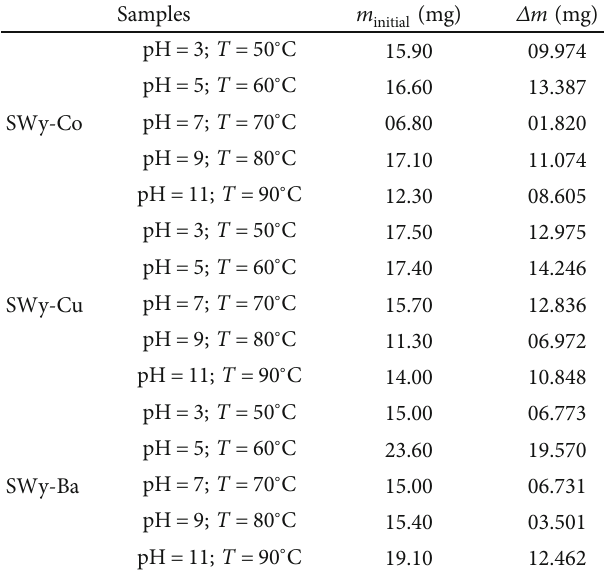
Table 8: Results from TG/DTA analyses in the case of samples SWy-Co, SWy-Cu, and SWy-Ba.